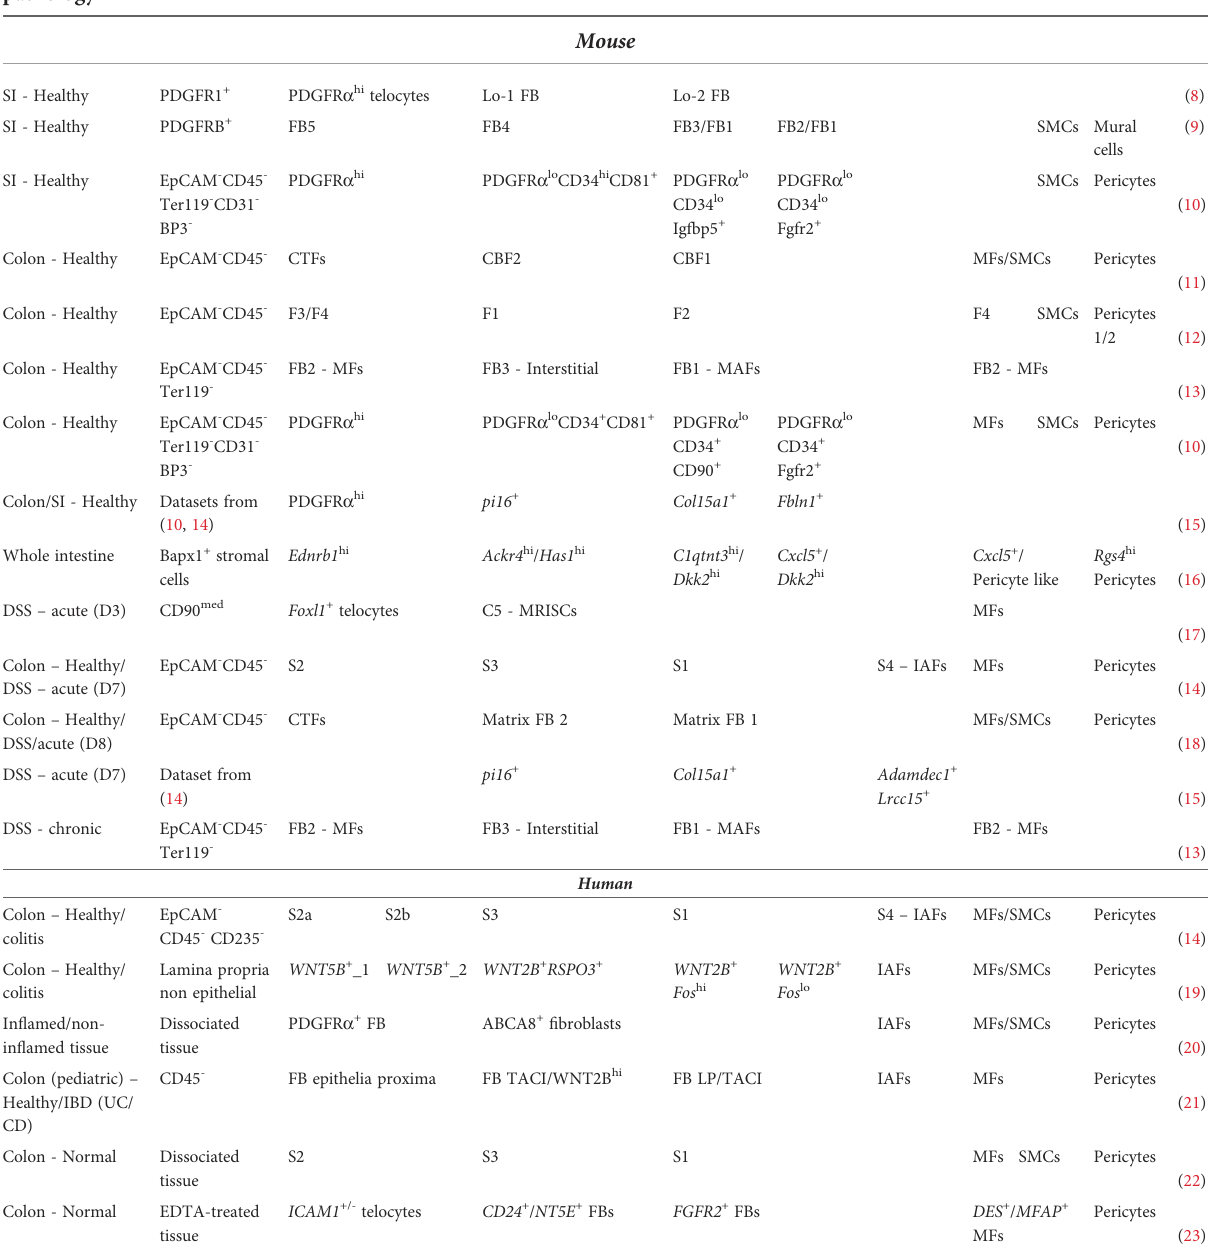
TABLE 1 Comparison of fi broblast subsets from recent single cell RNA sequencing